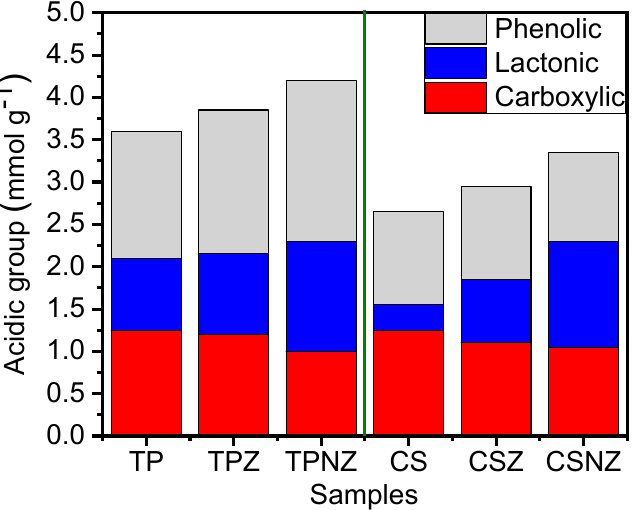
Figure 6. Acidic groups of TP and CS samples, before and after pretreatment.